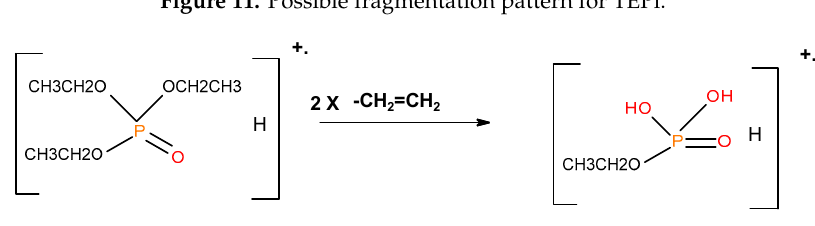
Figure 11. Possible fragmentation pattern for TEPi.